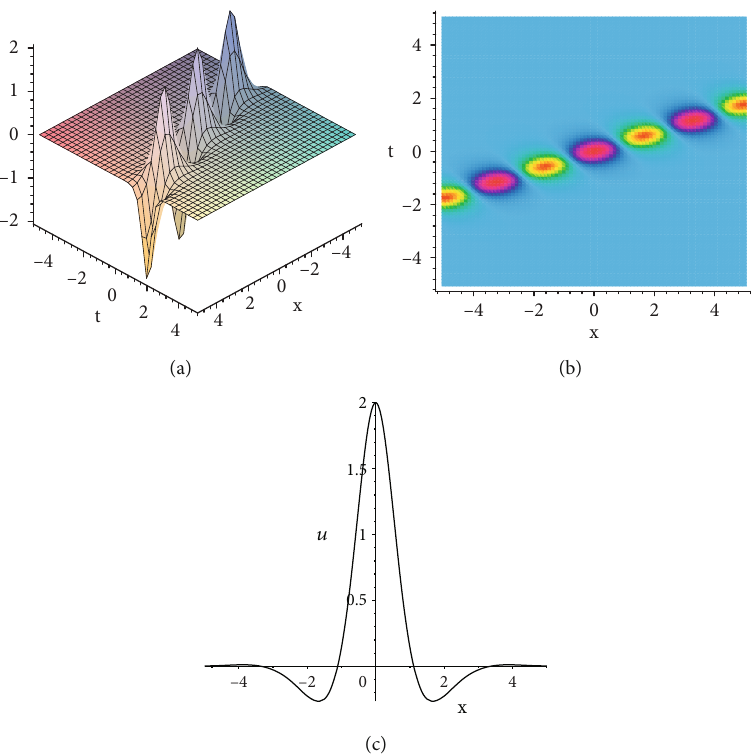
ffiffiffi p ffiffiffi p 2 − 4 , c = 1 , α = 2 , β = γ = 0 ,